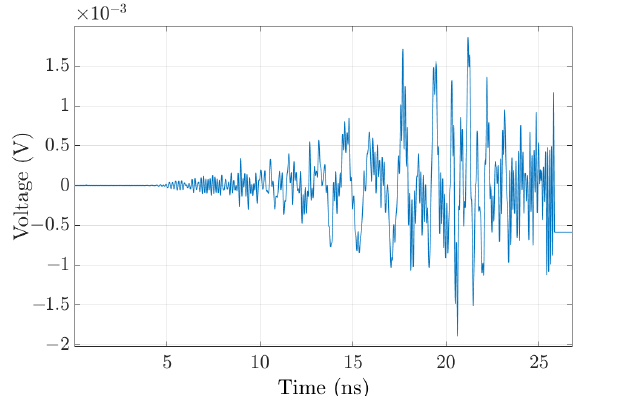
Figure 18. Measuring the reflected voltage generated by the far anti-dipole Vivaldi antenna on an epoxy-resin blade with one crack and with two